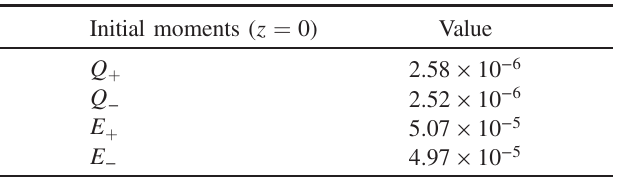
TABLE III. Initial moment values when solving the equations from Eq.